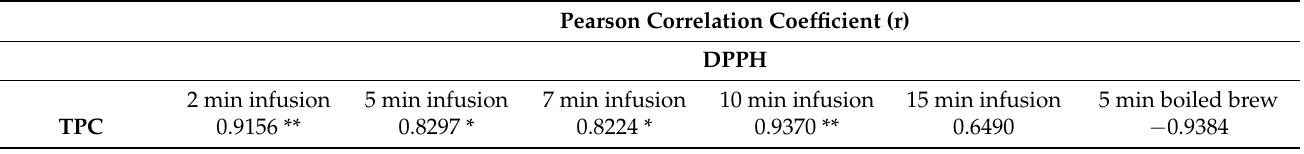
Table 5. Pearson correlation coefficients of TPC and DPPH at different times of infusion. Pearson Correlation Coefficient (r)